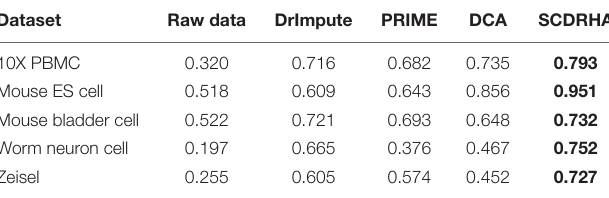
TABLE 5 | NMI score under different datasets. TABLE 6 | ARI score under different datasets.